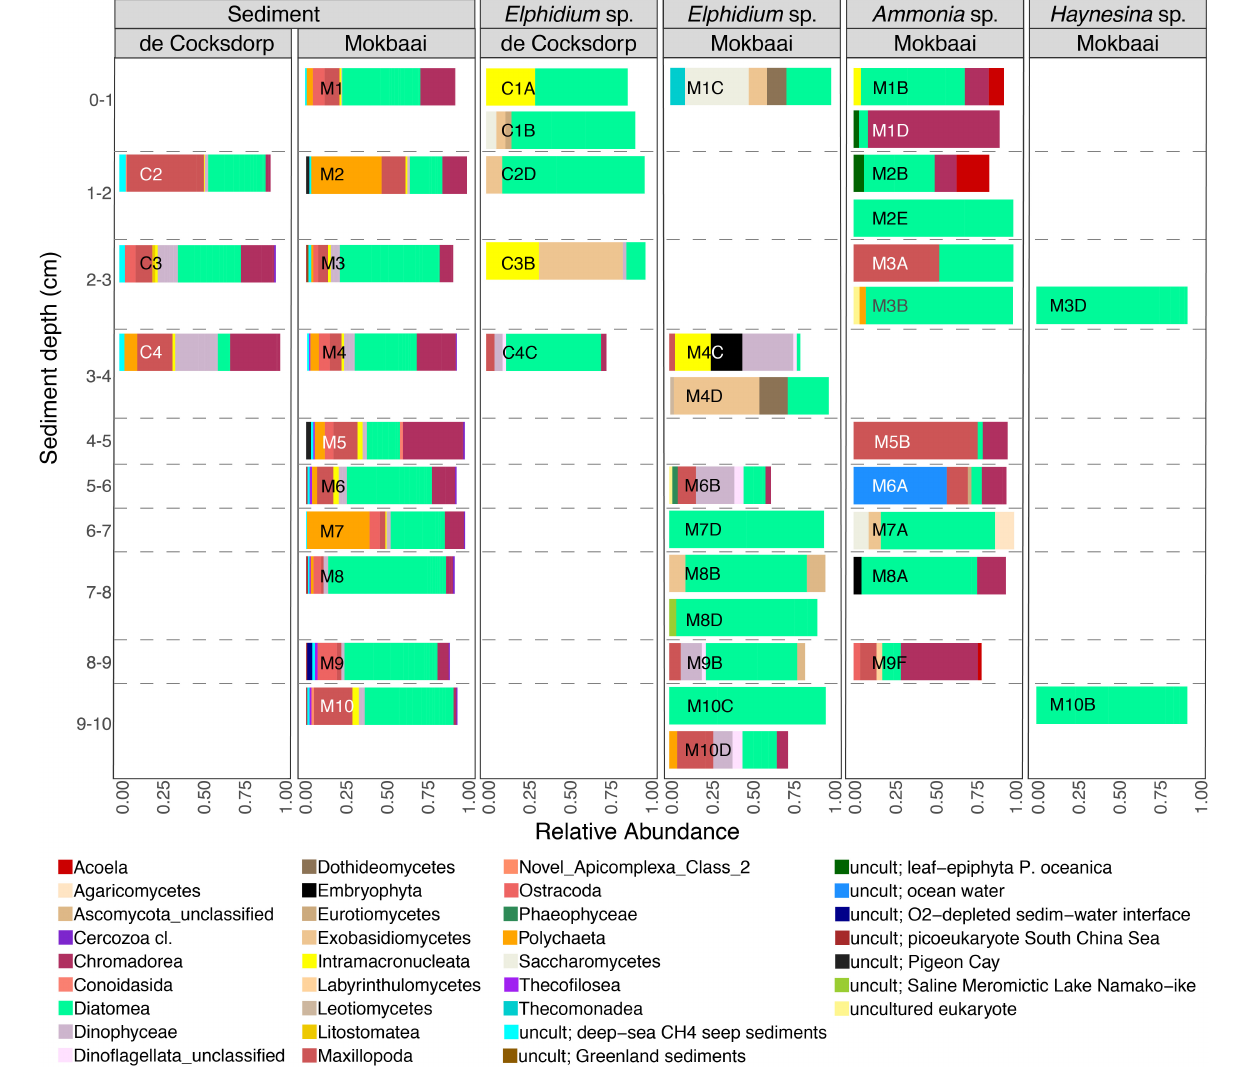
FIGURE 2 | Relative abundance of eukaryote taxa at class level for foraminiferal intracellular eukaryote content (showing classes with > 2% abundance, i.e., 90.02% of all reads; foraminiferal OTUs excluded from the analyses) and communities of the surrounding sediments (showing classes with > 0.5% abundance, i.e., 83.20% of all reads). Foraminiferal species ( Ammonia sp., Elphidium sp., Haynesina sp.) and sampling sites (de Cocksdorp, Mokbaai) are shown on the top grid. Taxa that are similar to uncultured eukaryotes are indicated by “uncult” followed by information on the environment of their closest